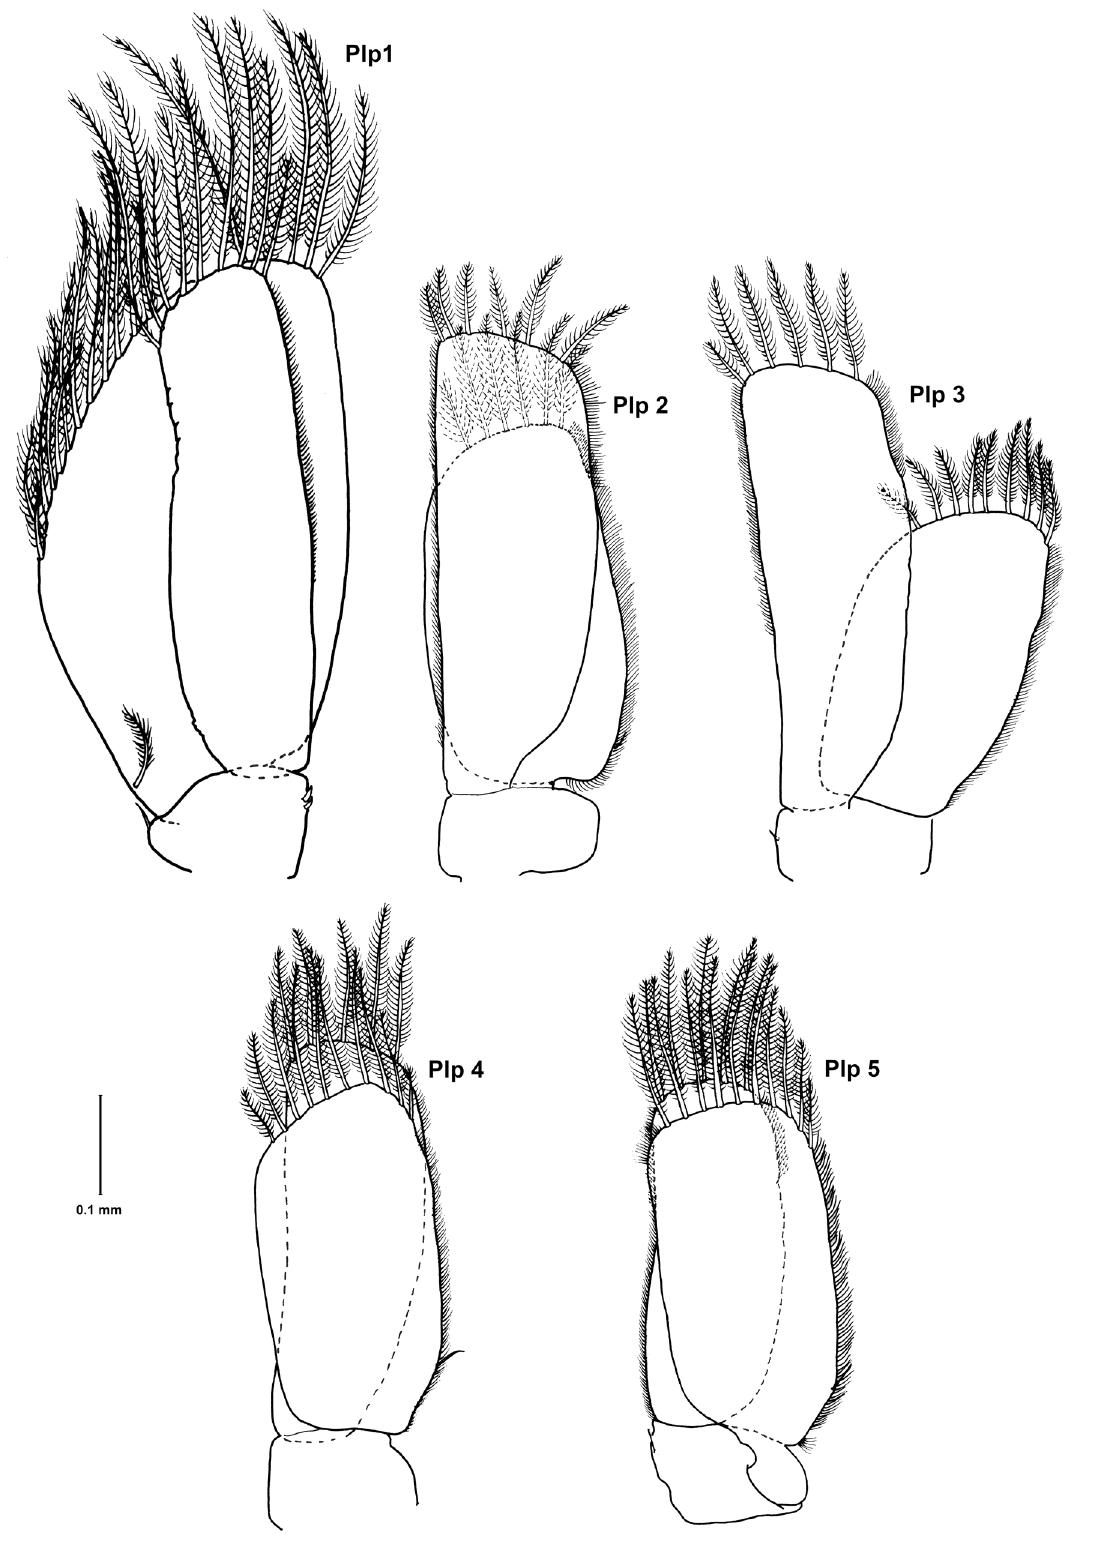
Fig. 16. Pendanthura bangkaensis sp. nov., ♀, holotype (MZB Iso 104). Abbreviations: Plp 1–Plp 5 = pleopods